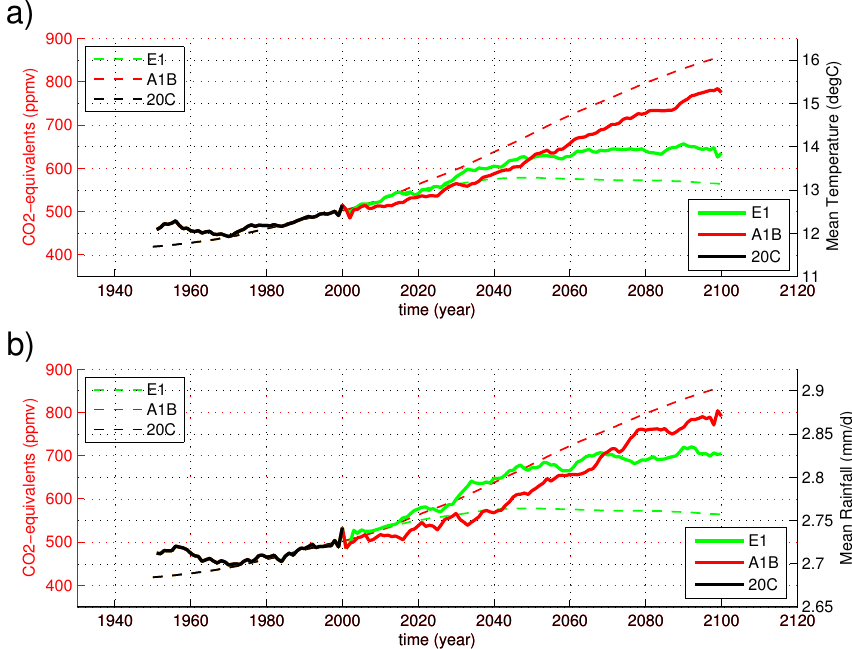
Fig. 4. Time evolution of 5-yr running means for globally-averaged (a) near surface temperature and (b) precipitation (right axis solid lines) vs. GHGs concentration (left axis dashed lines) for the observed historical period 1950–2000 (20C; black), A1B (red) and E1 (green).